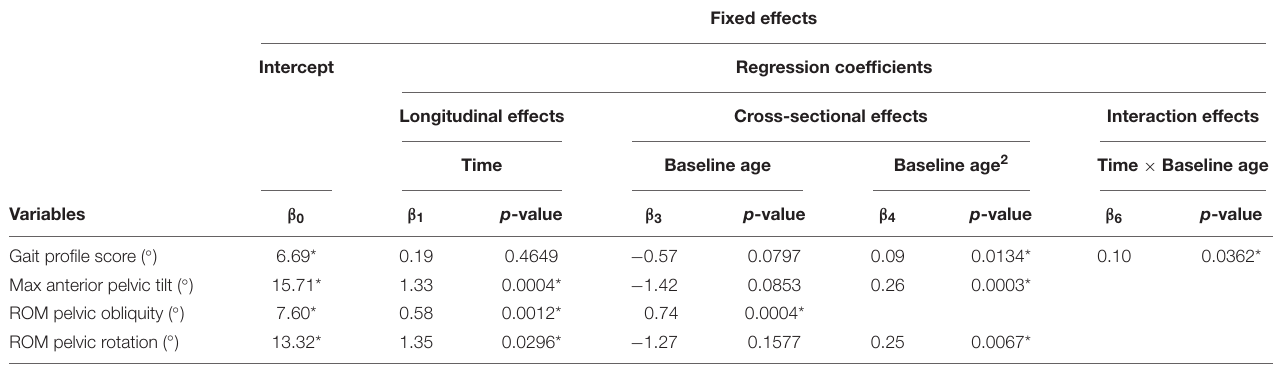
TABLE 4 | Results of linear mixed effect models with the gait profile score and pelvis kinematics as responses in children with DMD.